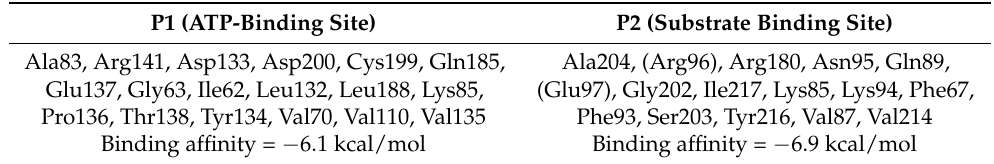
Figure 4. Two-dimensional Ligplot + diagram of the interaction between DBP and amino acid residues on the substrate-binding site (P2) of GSK-3 β . Double-bonded oxygen of ester groups in DBP form hydrogen bonds (blue dotted lines) with Arg96 and Glu97. Red, spoked arcs represent hydrophobic interactions between DBP and amino acid residues of P2. Oxygen is red, nitrogen is blue, and carbon is gray circles. Table 3. A summary of DBP-interacted amino acid residues on P1 and P2 [25] as analyzed by Molegro docking software. Enclosed and non-enclosed residues are hydrogen bond formations and hydrophobic interactions between GSK-3 β with DBP,